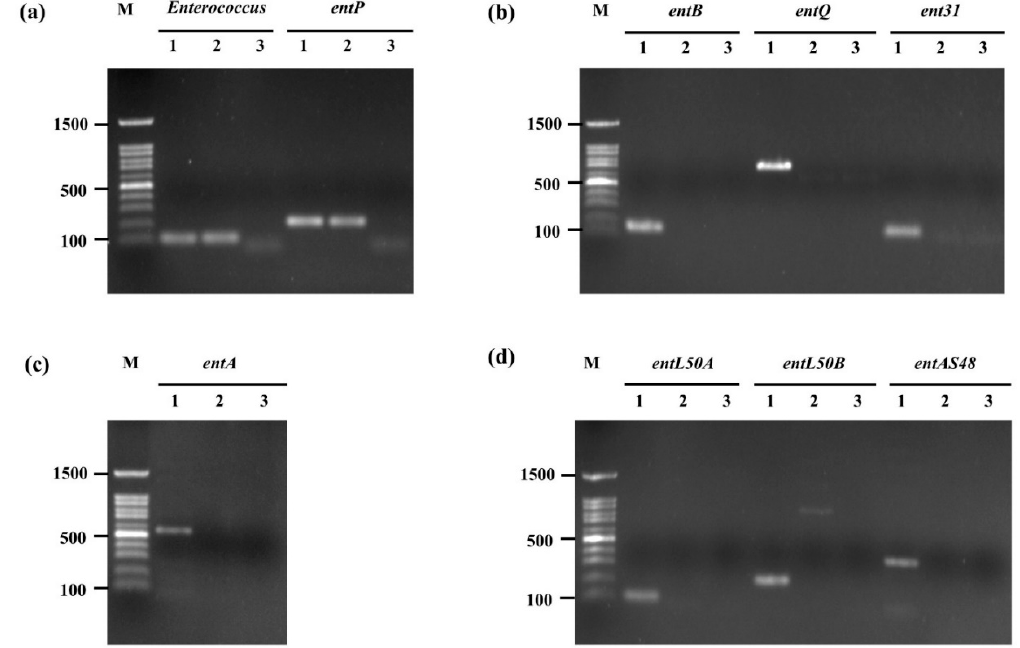
Figure 3. Amplification of genus Enterococcus gene and bacteriocin genes in E. faecium OV3-6 by PCR. ( a ) Genus Enterococcus and entP genes; ( b ) entB , entQ , and ent31 genes; ( c ) entA gene; ( d ) entL50A , entL50B , and entAS48 genes; Lane M: 100 bp DNA markers; Lanes 1: products of positive controls; Lanes 2: products of E. faecium OV3-6; Lanes 3: products of negative controls.